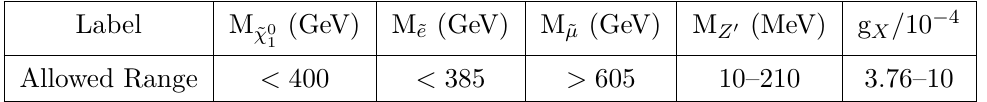
Table 2. Allowed physical neutralino, selectron and smuon masses as well as additional gauge boson mass and coupling that can explain both electron and muon ( g − 2) . Unlisted physical states/ parameters remain viable throughout their scanned